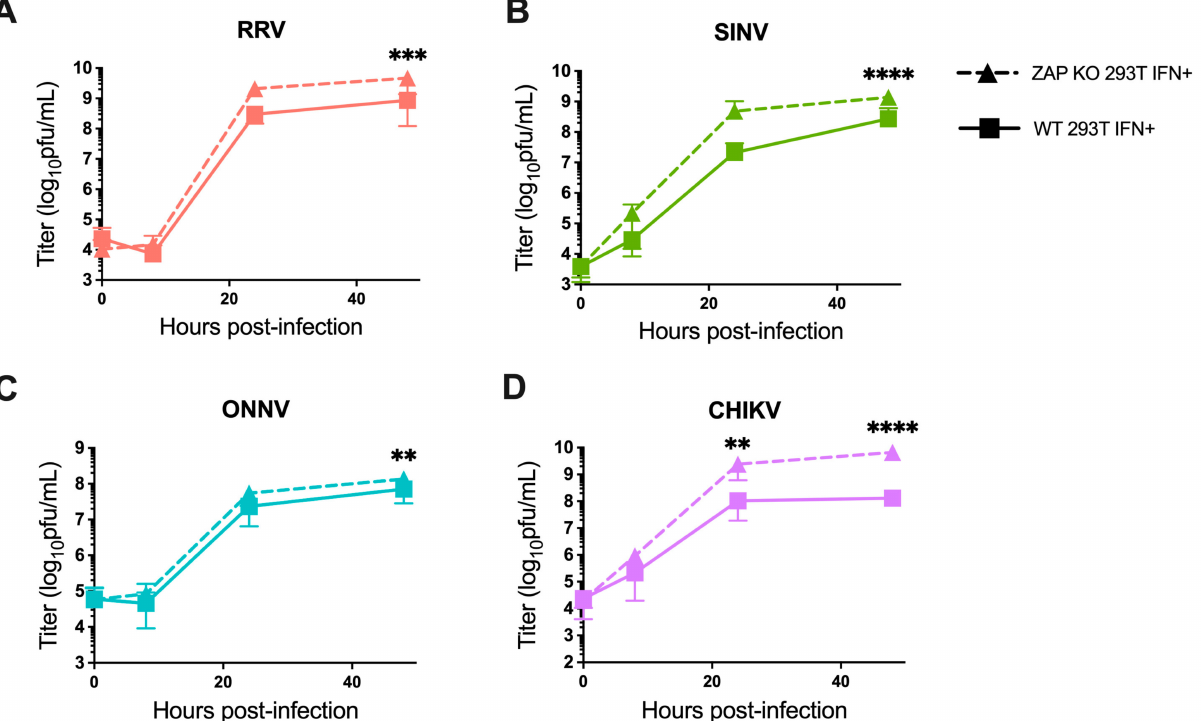
Figure 2. Alphavirus production shows differential sensitivity to IFN-induced endogenous ZAP in 293T cells. Following treatment with 5 U/mL IFN- β for 24 h, ZAP KO and WT 293T were infected with RRV ( A ), SINV ( B ), ONNV ( C ), and the CHIKV vaccine strain (181/clone 25) ( D ) at MOI = 0.1 PFU/cell. Media overlaying the cells were harvested at 0, 8, 24, and 48 h.p.i., and the viral titer was determined by infection of BHK-21 cells in standard plaque assays. Mean values from four biological replicates across two independent experiments are plotted, and error bars represent the SD. Asterisks indicate statistically significant differences (two-way ANOVA and Bonferroni posttest: **, p < 0.01; ***, p < 0.001; ****, p <